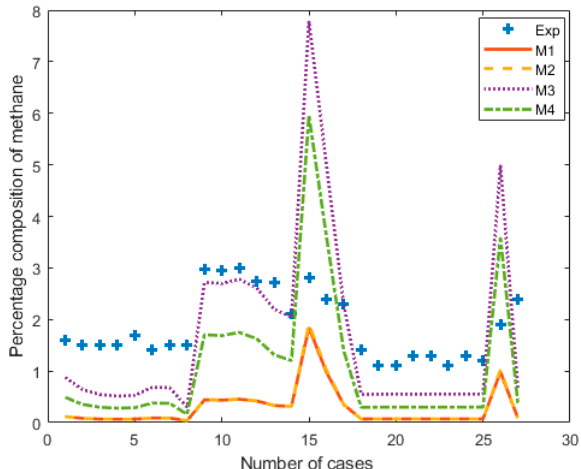
Figure 6. Comparison of the methane composition with experiments and models.